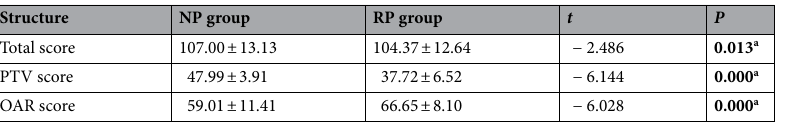
Table 4. Evaluation comparison for the score of RP group and NP group (mean ± SD). *a = Paired t test, Wilcoxon test, P < 0.05. Bold values indicates that the difference is statistically significant ( P <0.05)